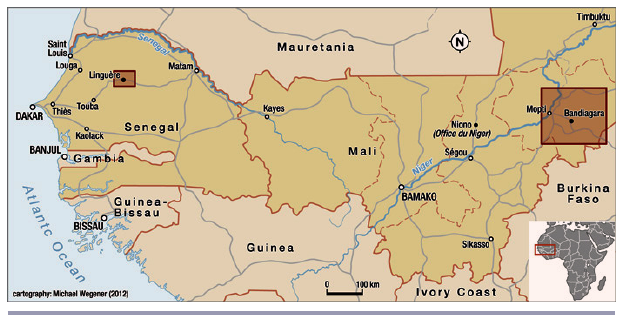
Fig. 1. Location of the study areas in Linguère, Senegal, and in Bandiagara,